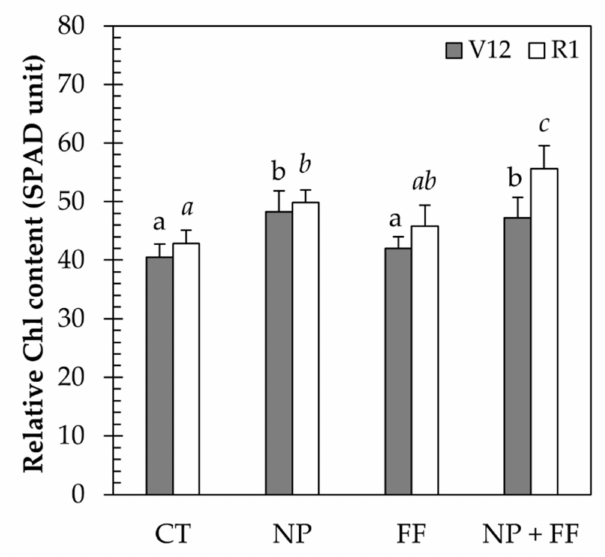
Figure 2. The relative chlorophyll (Chl) content of maize leaves due to each treatment at different phenological stages (V12 and R1). Data represent mean ± SD (n = 25). CT: untreated control; FF: foliar fertilizer; NP: nitrapyrin; NP + FF: joint treatment of nitrapyrin and foliar fertilizer. Different lowercase letters denote significant differences (one-way ANOVA and Duncan’s multiple range test, p ≤ 0.05) between the different